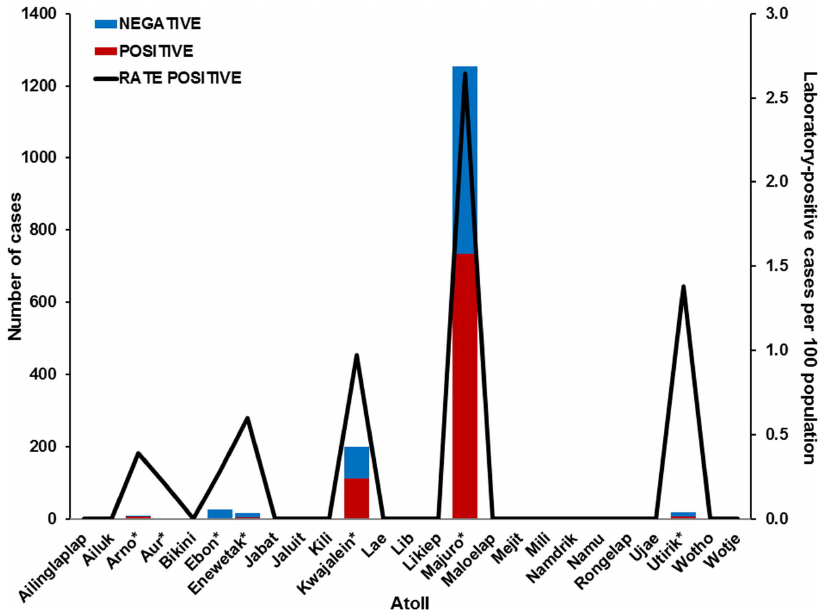
Figure 2. Atoll of residence of suspected dengue cases identified in the Republic of the Marshall Islands, October 2011–February 2012. Laboratory case definition and atoll of residence were compiled as indicated. Asterisks indicate atolls with laboratory-positive cases. Ebeye island is located on Kwajalein atoll.